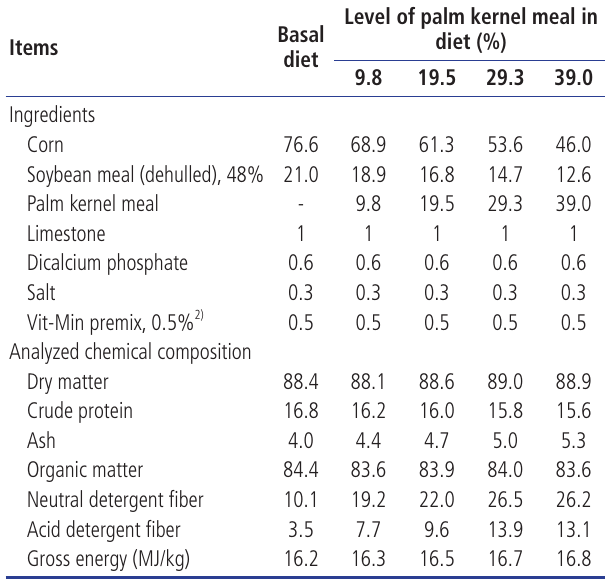
Table 2. Ingredients and analyzed chemical composition of experimental diets (as-fed basis, %)